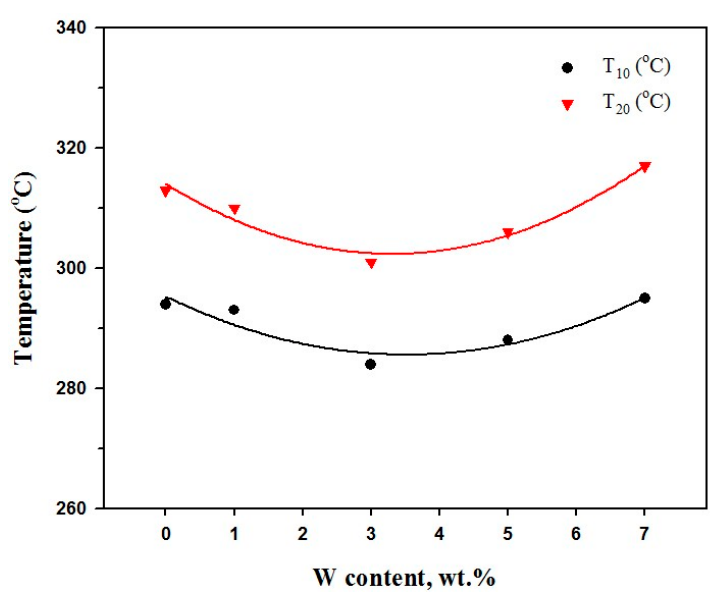
Figure 9. Temperatures corresponding to soot conversion rates of 10% (T 10 (°C)) and 20% (T 20 (°C)) as a function of the tungsten content in Pt–W[x]/TiO 2 catalysts. Reaction conditions: catalyst/soot = 8:2; reactant gas = 300 ppm NO, 3 ppm SO 2 , 10% O 2 , 5% H 2 O, and N 2 balance; total flow = 0.1 L/min; GHSV = 50,000 h − 1 .